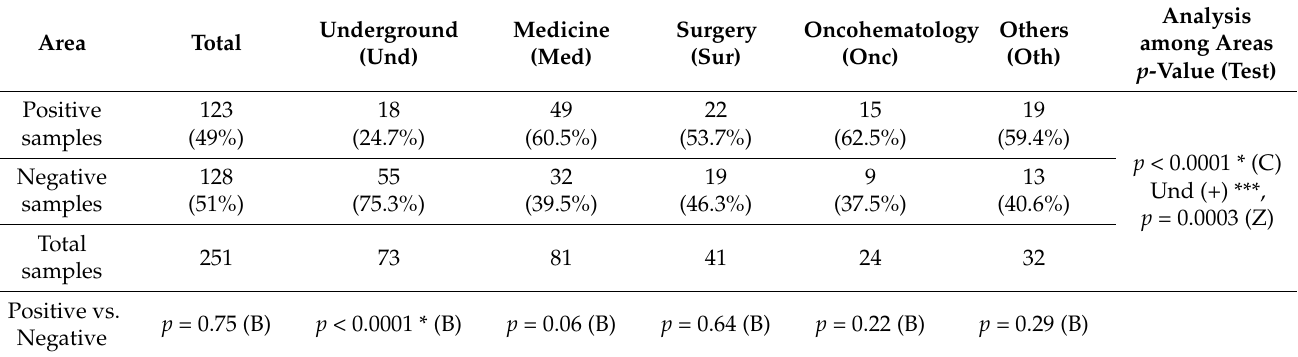
Table 1. The rates of positive and negative samples for Legionella spp.